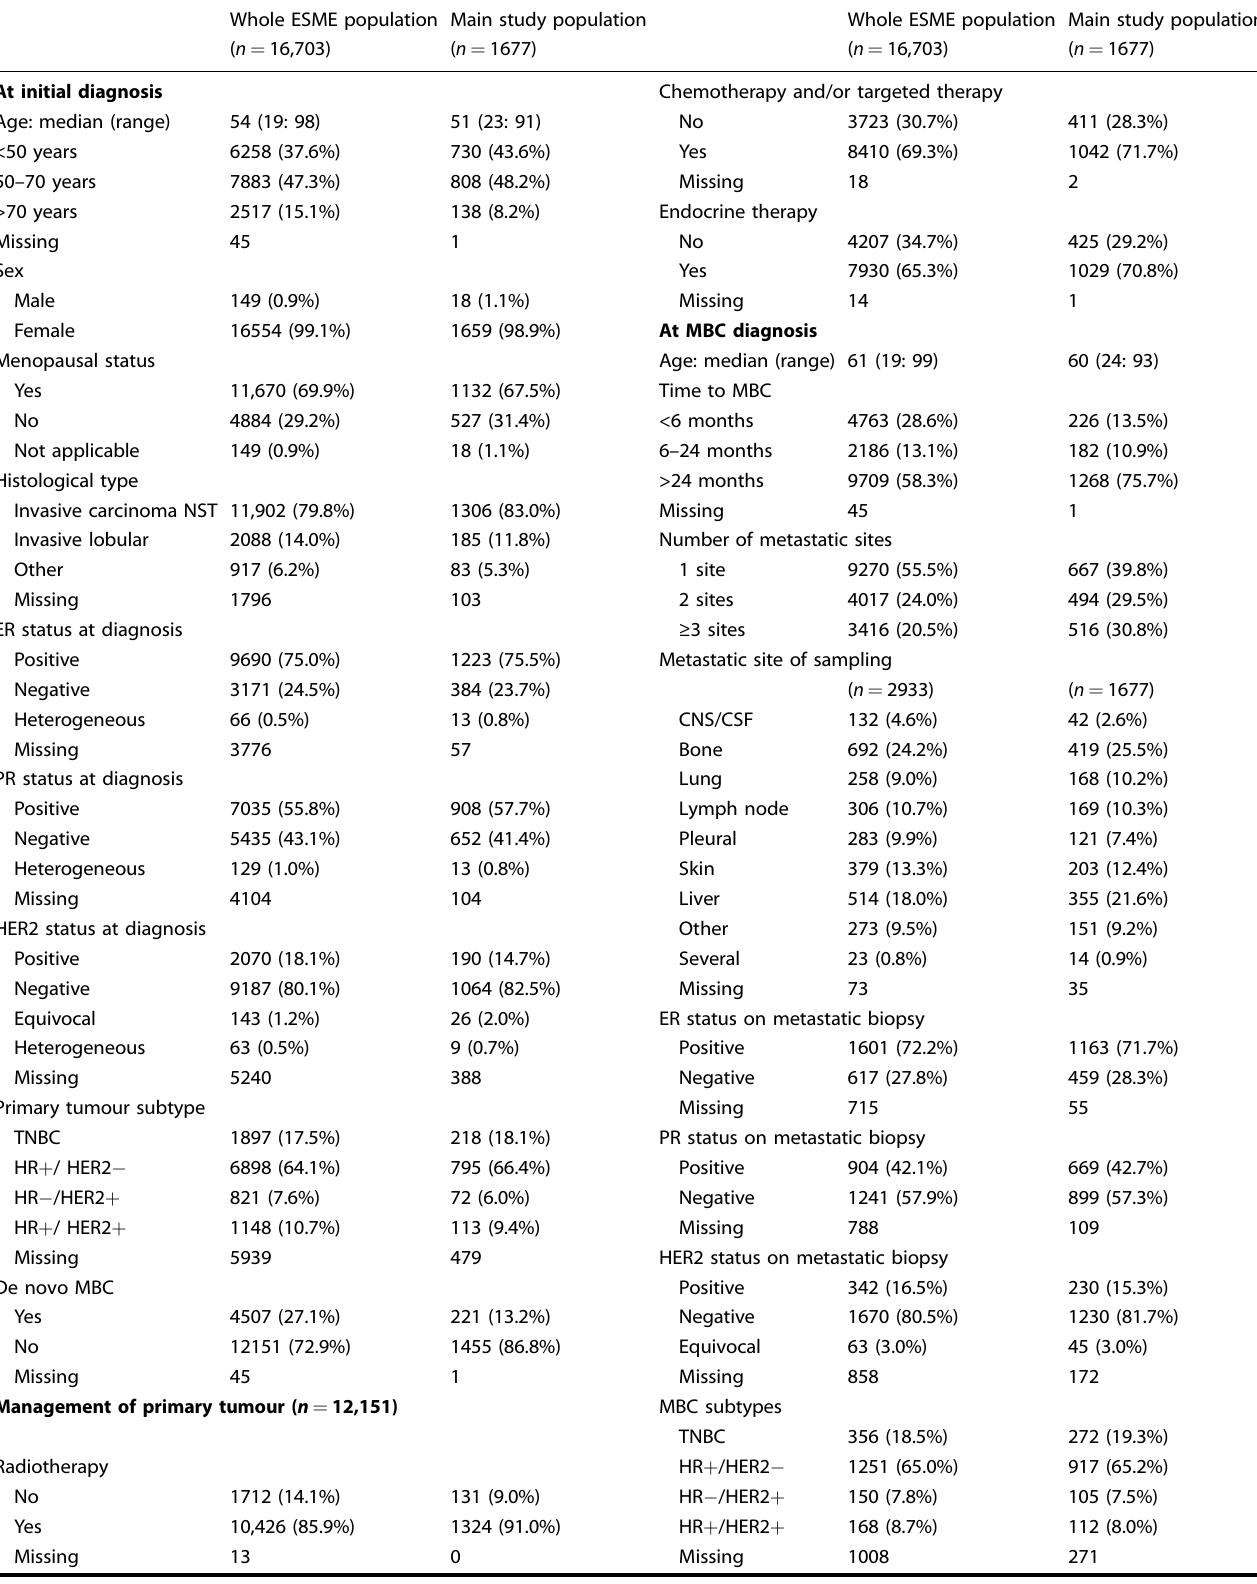
Table 1. Clinical and histological features of the primary tumour and metastatic disease in the ESME cohort and main study population. Whole ESME population Main study